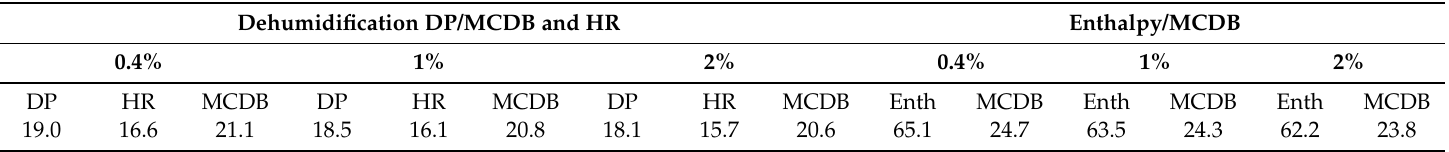
Table 6. Climatic design conditions (c) for Harare, Zimbabwe